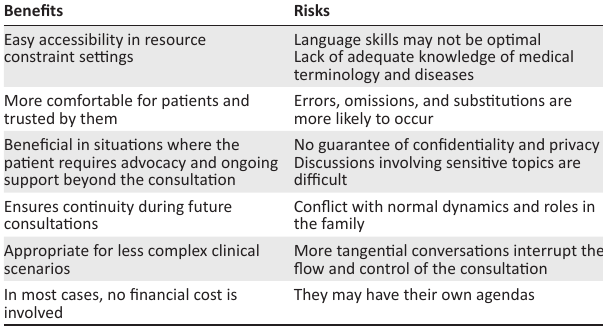
TABLE 1: Potential benefits and risks of using untrained family and/or friends for healthcare